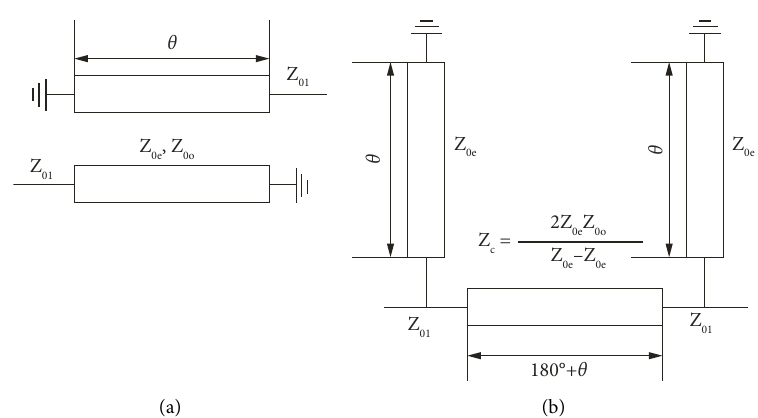
Figure 2: (a) Structure of coupled microstrip line with two shorts. (b) Equivalent circuit